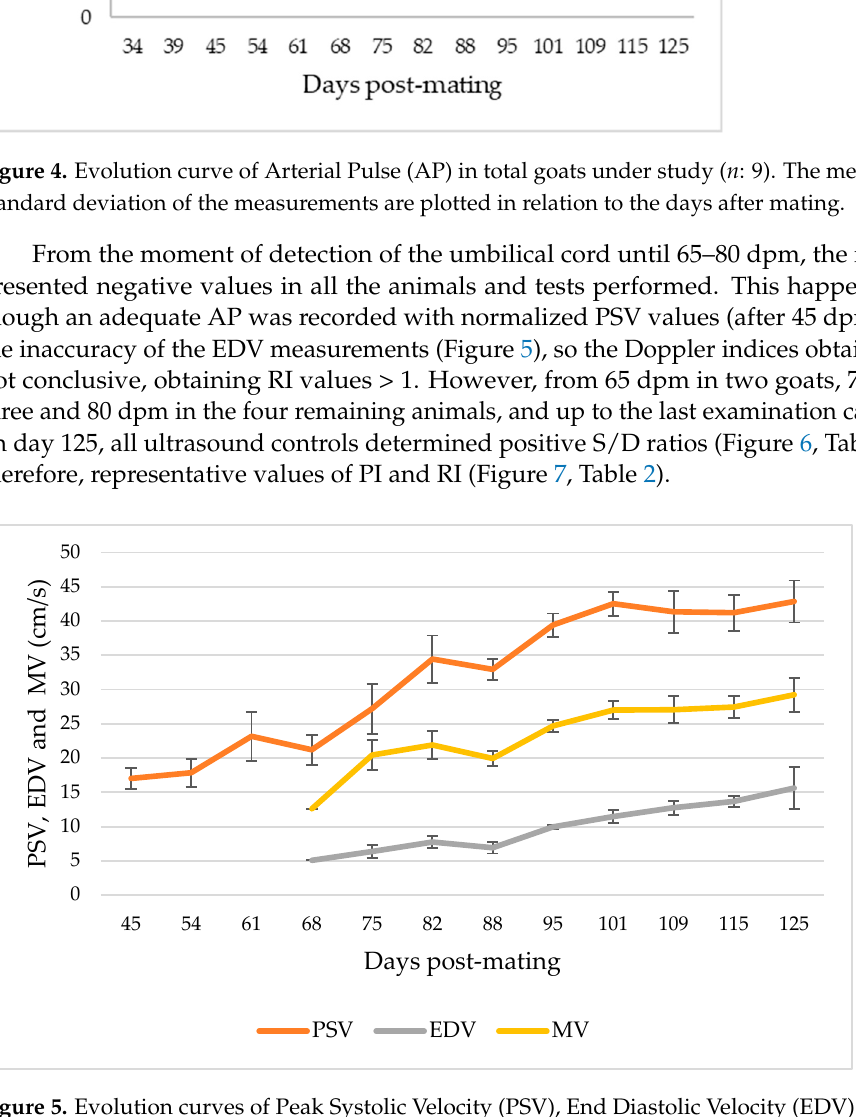
Figure 6. Evolution curve of Systolic/Diastolic ratio (S/D) in total goats under study ( n : 9). The mean and the standard deviation of the measurements are plotted in relation to the days after mating.